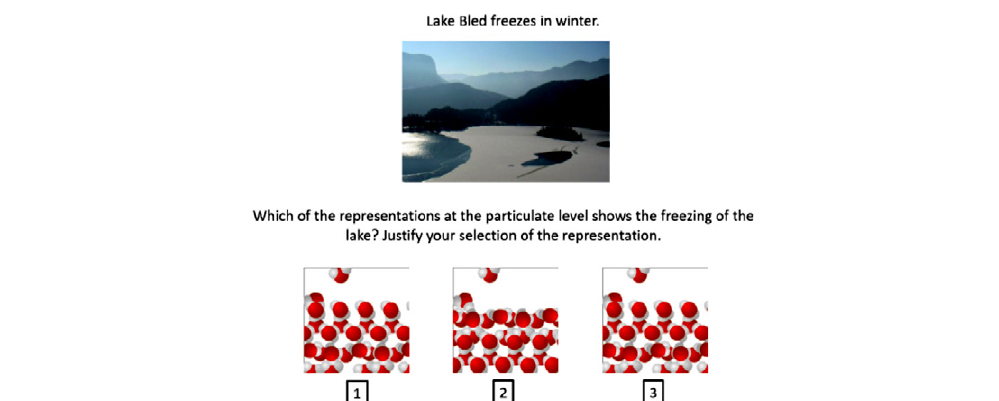
Figure 3. Screen image of the third authentic task. (Image of lake Bled from www.wikipedia.org). All SMRs represented the movement of water molecules in three different states of matter. All SMRs represented the correct movement and arrangement of particles (water molecules) in the gaseous state of water (on the top of SMR). The correct one is SMR 1 representing the liquid state in the lower part, the solid state in the middle part of the SMR, and the gaseous state in the upper part. SMR 2 did not represent the arrangement of the particles in the correct order (solid state in the lower part, liquid state in the middle part of the SMR, and gaseous state in the upper). SMR 3 is incorrect because particles do not move in the solid state of